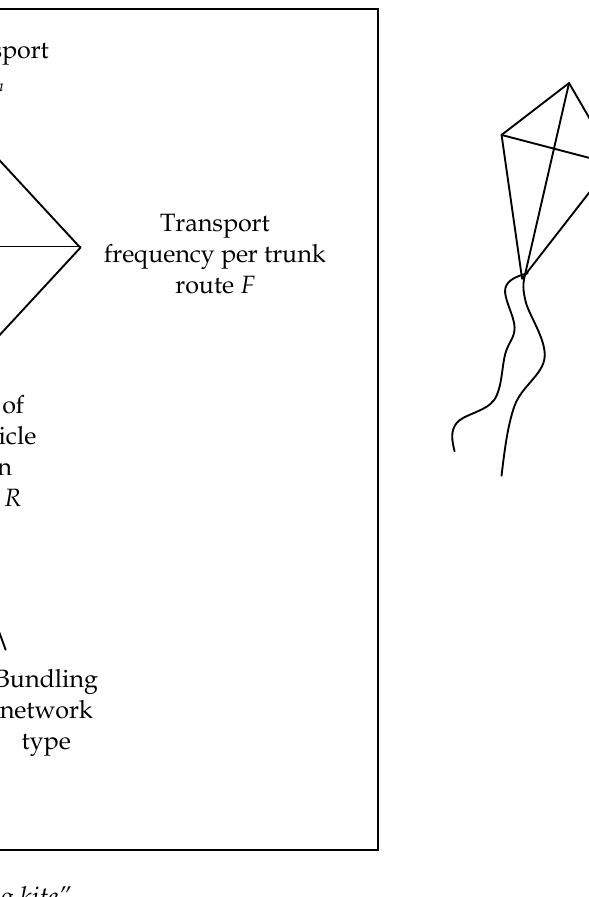
Figure 3. The variables of the “bundling